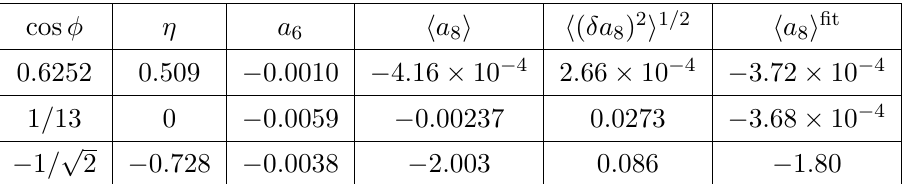
Table 1 . Collective spectral fluctuations as measured by the coefficient a 8 in the expansion of the spectral density in Q-Hermite polynomials. The fitted value of a 8 is within the range of these